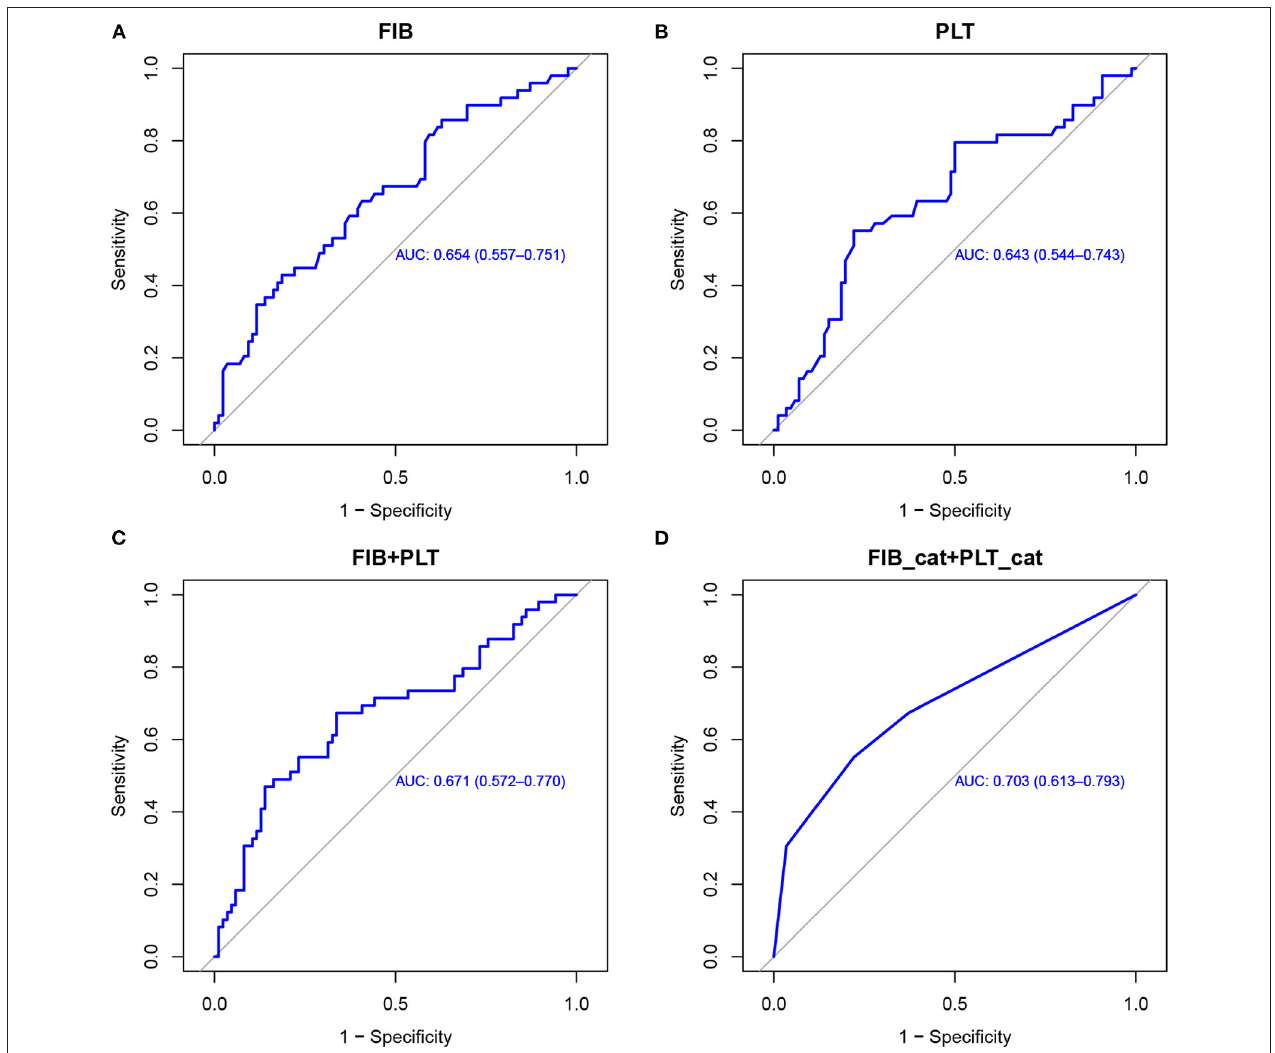
FIGURE 1 | ROC curves used to evaluate the predictive utility of risk factors for HT in AIS patients with MT. Utility of fibrinogen levels (A) , platelet counts (B) , fibrinogen combined with platelets (C) , and a combination of the binary variates fibrinogen (2.165 g/L) and platelets (171.5 × 10 9 /L) (D) for predicting HT. ROC, receiver operating characteristic; HT, hemorrhagic transformation; AIS, acute ischemic stroke; MT, mechanical thrombectomy; FIB, fibrinogen; PLT, platelets.